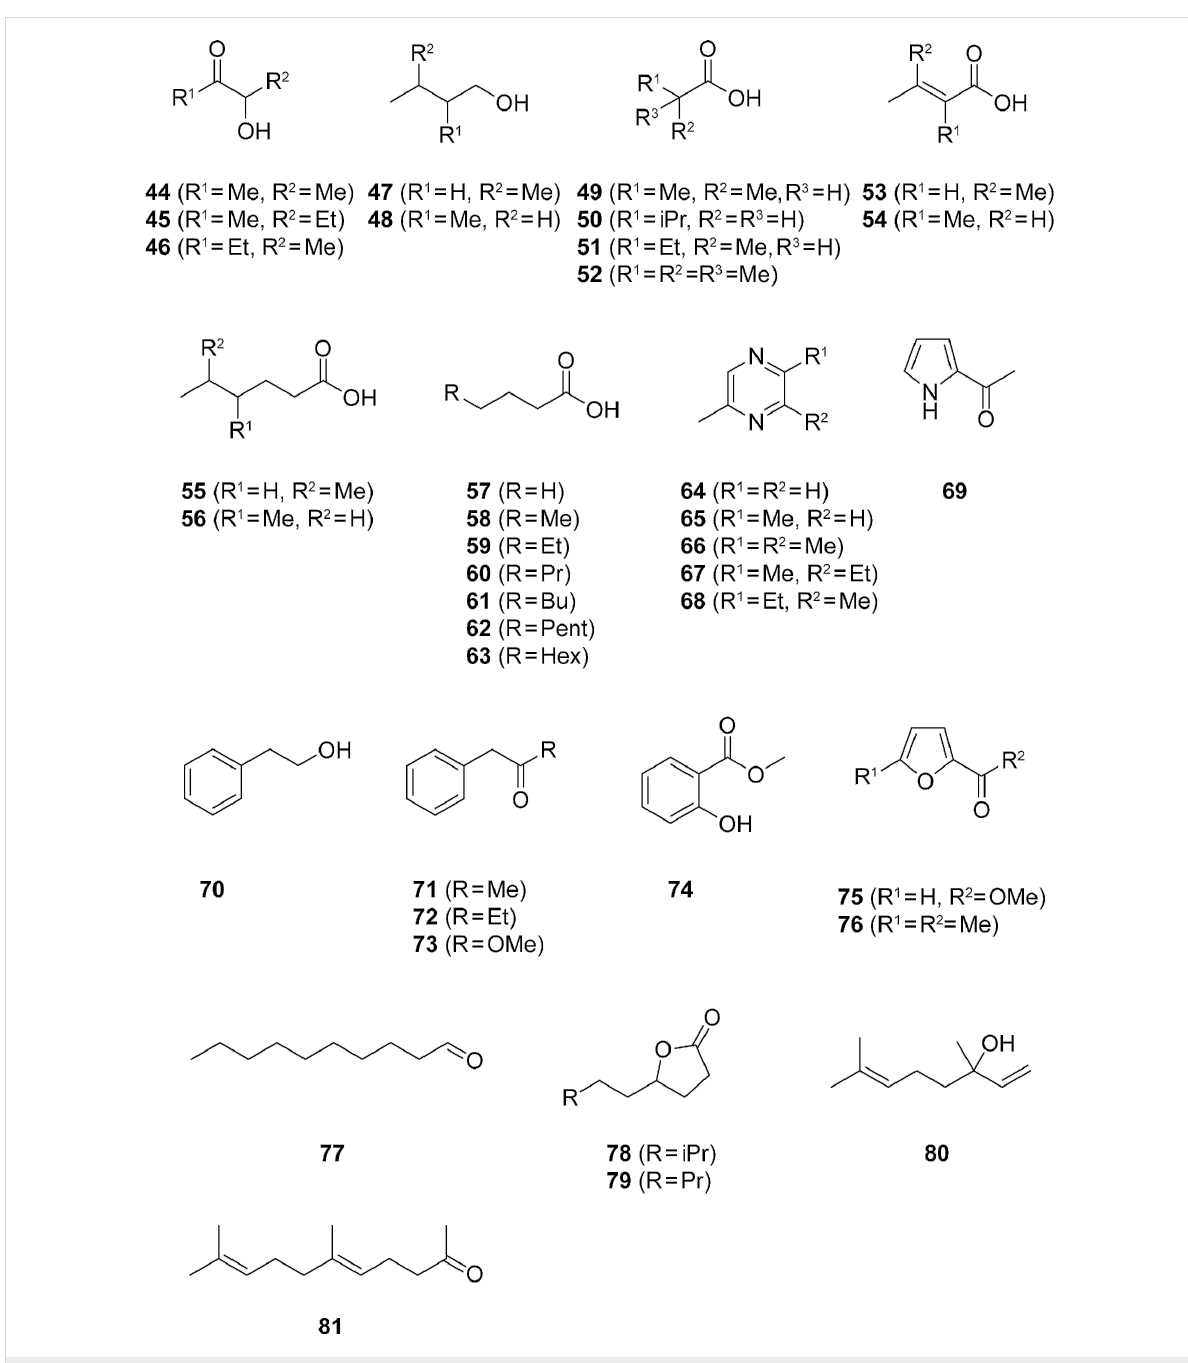
Figure 2: Compounds found in the headspace extracts of M. aurantiaca .